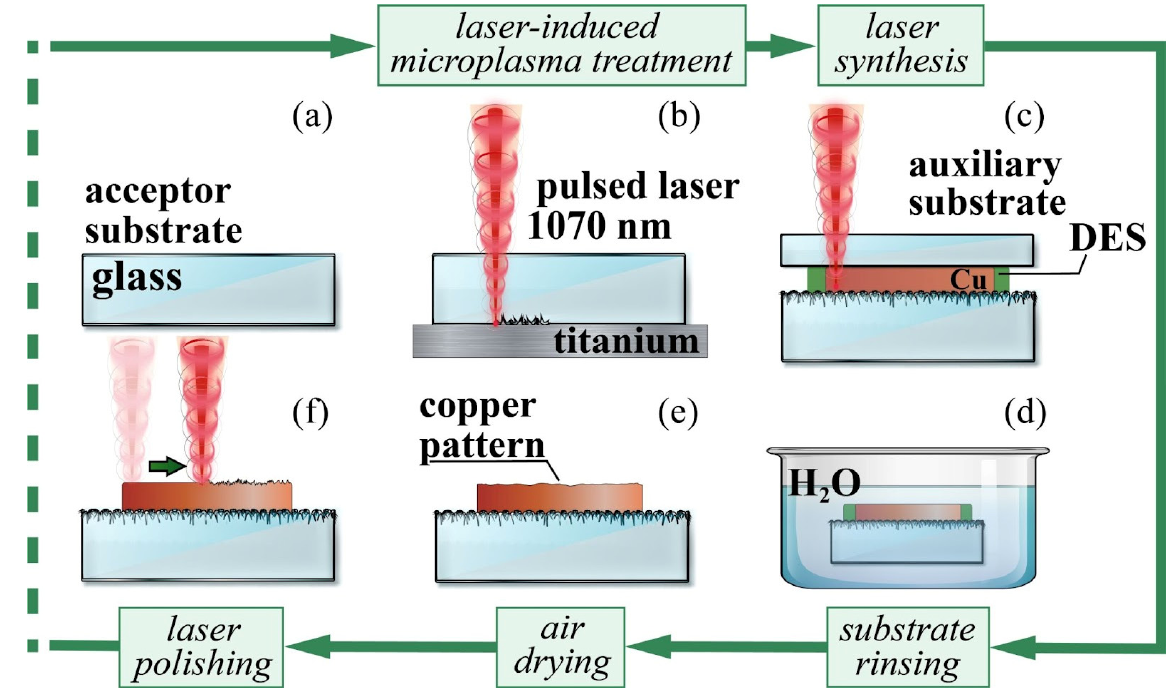
Figure 1. Laser-induced deposition technique. ( a ) plain glass substrate; ( b ) laser-induced micriplasma processing; ( c ) fabrication of the copper patterns under action of laser radiation; ( d ) rinsing away the leftovers of the DES layer; ( e ) air drying; ( f ) laser polishing (optional).